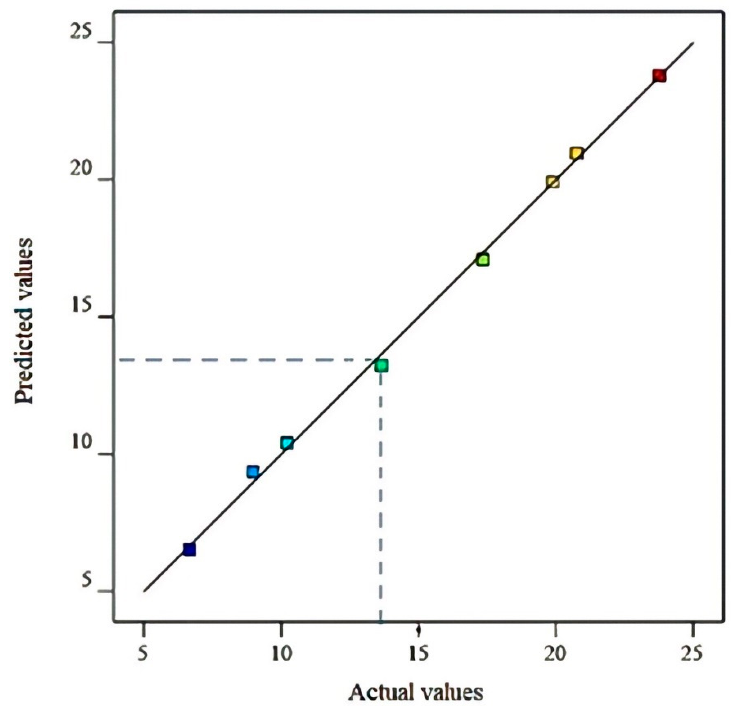
Figure 4. Diagnostic plots (predicted vs. actual) of model adequacy for the impregnation process. Table 4. Analysis of variance (ANOVA) for the model fitted to the SC-CO 2 impregnation process. df (Degree Source Sum of Squares Mean Square F-Value p -Value of Freedom)